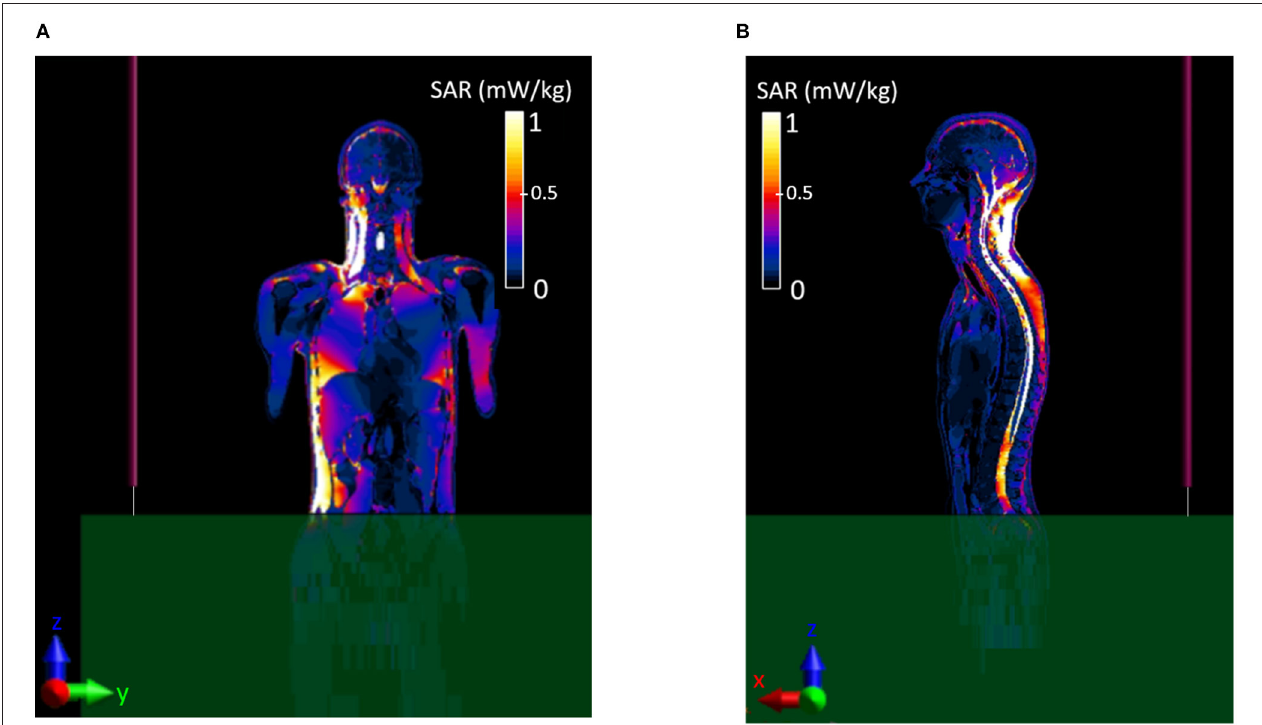
FIGURE 5 | Local distribution of the induced SAR inside the virtual body model Duke. (A) Coronal or frontal plane-YZ, (B) sagittal or lateral